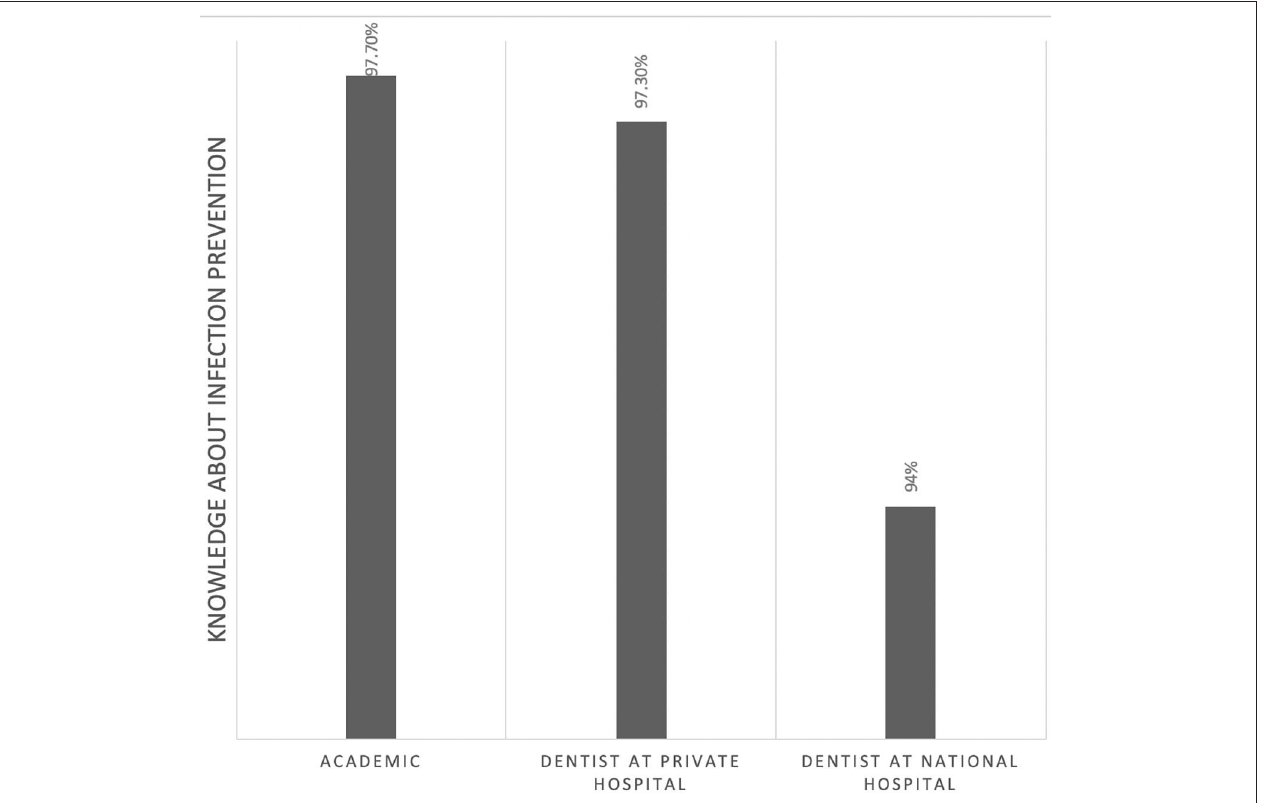
FIGURE 4 | Ninety-six percent of the participants were knowledgeable about infection prevention methods. The distribution showed a significant association between professional affiliation and knowledge ( p <